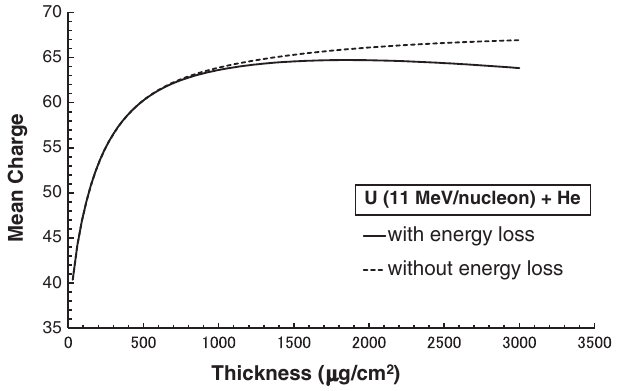
FIG. 7. Mean charge evolution of uranium ions at 11 MeV = nucleon with and without energy loss of the projectile as a function of thickness of He